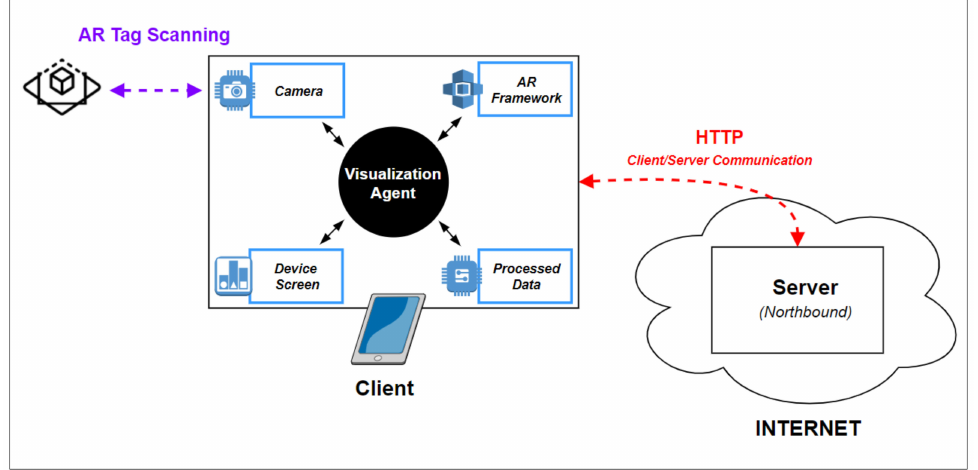
Figure 3. Visualization module architecture.